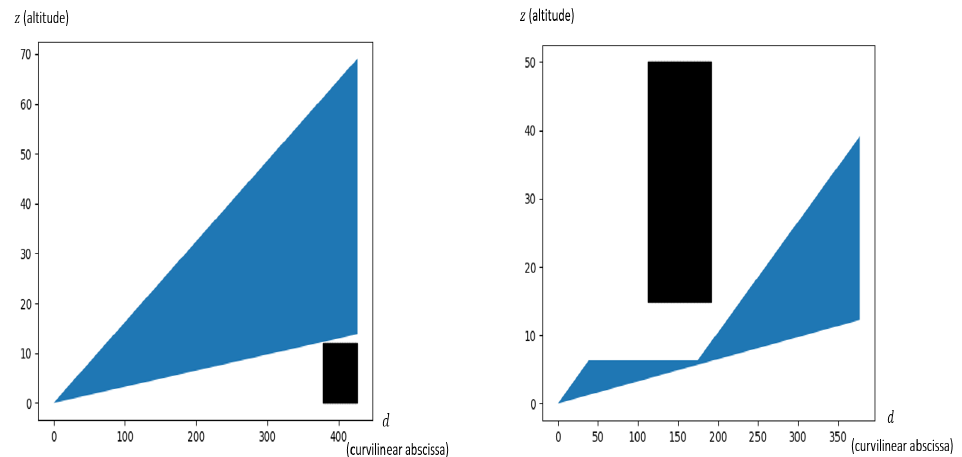
Figure 15. The result with all obstacles with a heavier